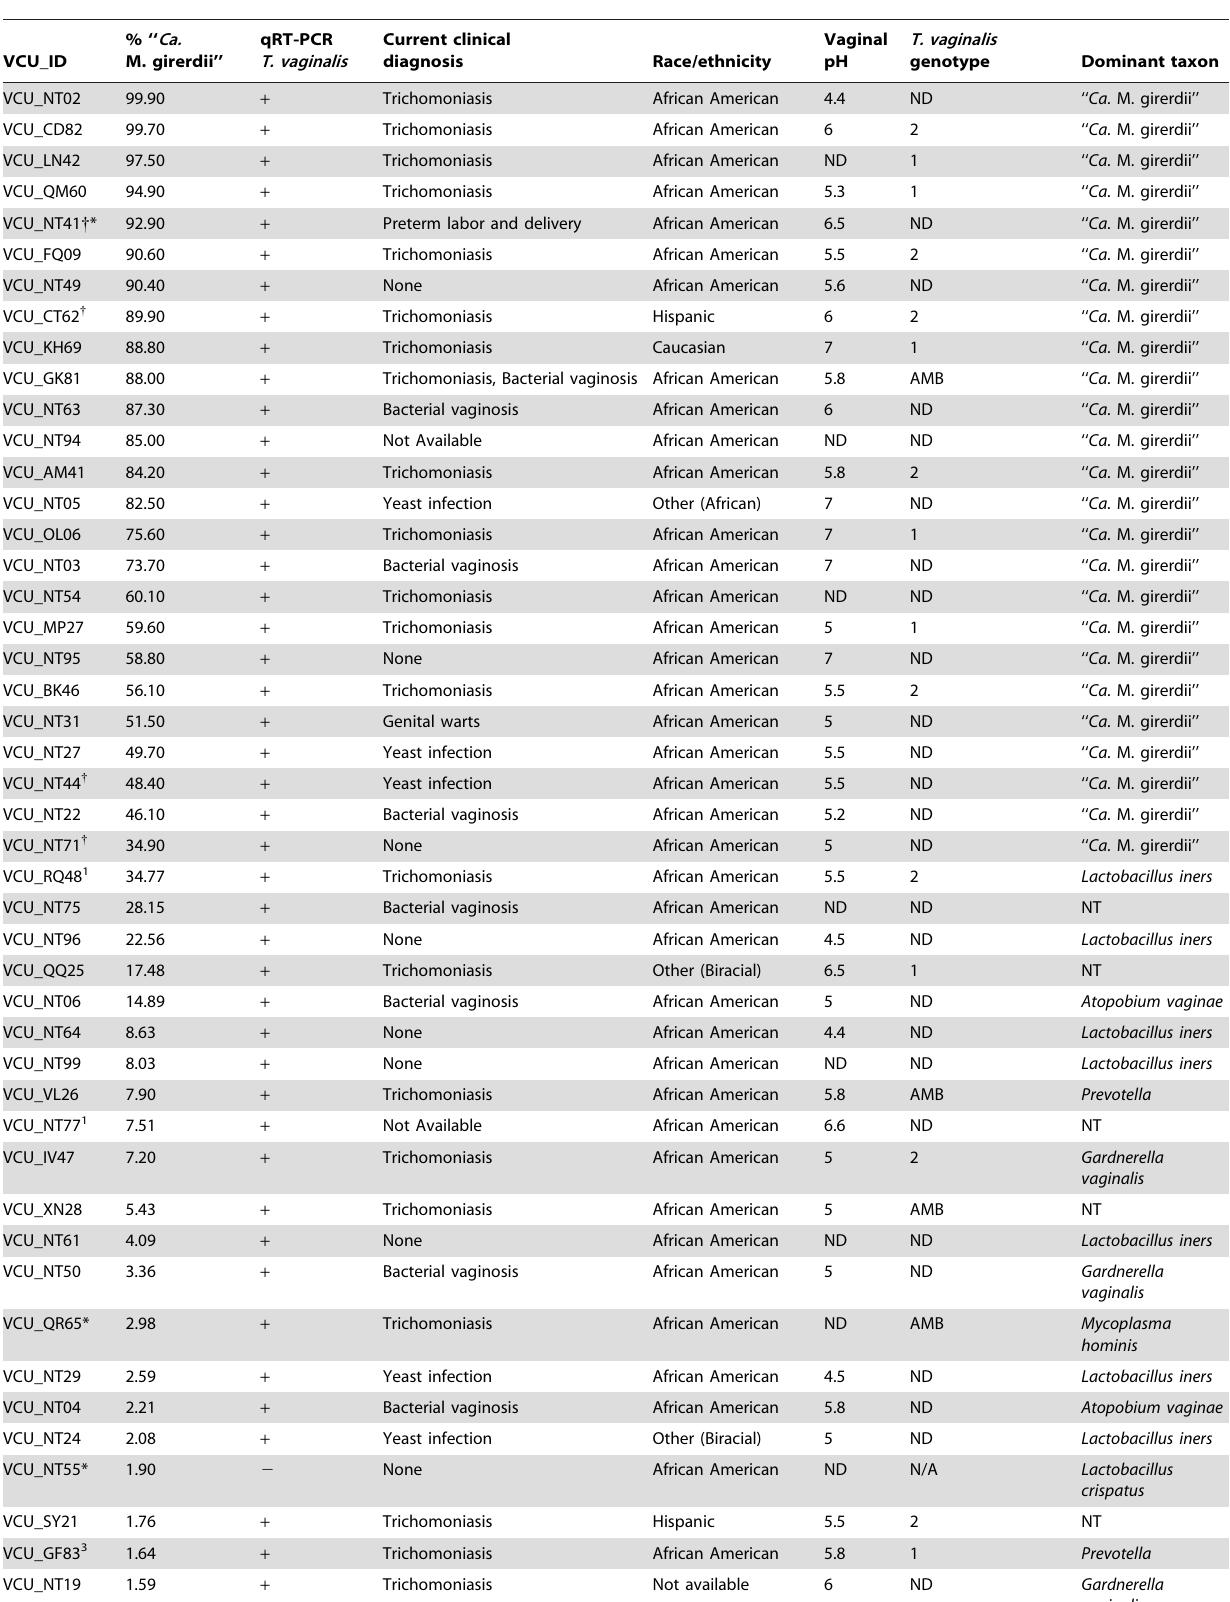
Table 1. Characteristics of 73 ‘‘ Ca . M. girerdii’’ positive vaginal